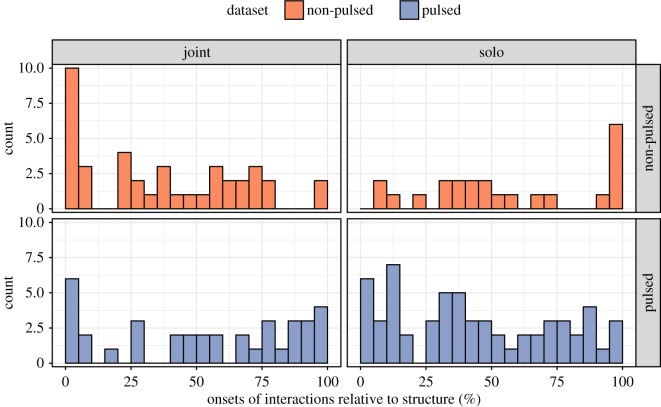
Onsets of annotated bouts of interaction across music structural sections and datasets. The x-axis shows the relative onset of each structural section (0–100%), and the y-axis indicates the frequency of the onsets of the annotated bouts of interaction.